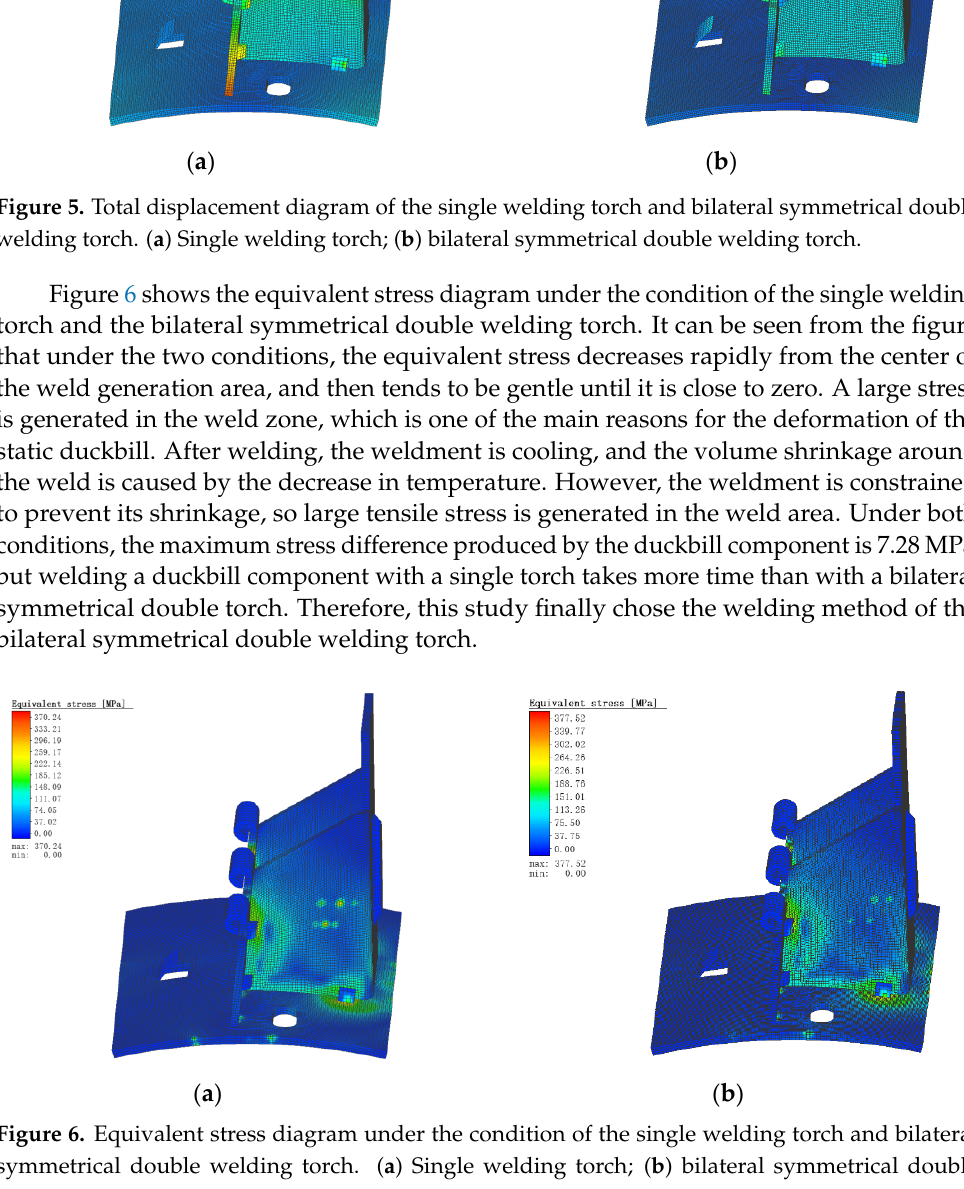
( b ) Figure 7. Total displacement diagram under continuous welding and spot welding conditions. ( a ) Continuous welding; ( b ) spot welding. Figure 8 is the equivalent stress diagram of continuous welding and spot welding. It can be seen from Figure 8 that the stress distribution of spot welding is smaller than that of continuous welding, and the difference in their maximum stress value is 121.89 MPa. Their stress distribution is similar, the stress distribution appears to diffuse from the weld to the distance and then weaken, but it is obvious that the stress distribution of continuous welding is wider and wider. This study finally chose the welding form of spot welding.